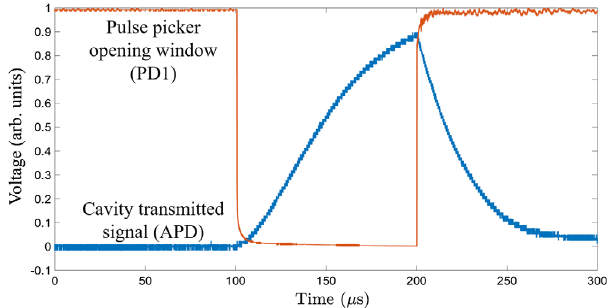
FIG. 6. Example of experimental signal traces (see text for details).